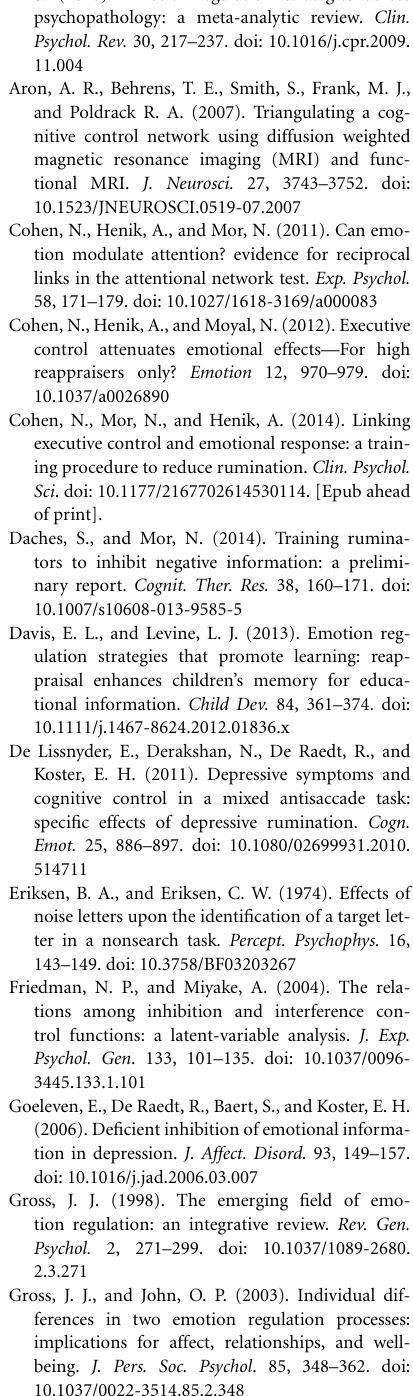
FIGURE 1 | The reciprocal causal links between the ability to inhibit negative content and rumination and reappraisal.